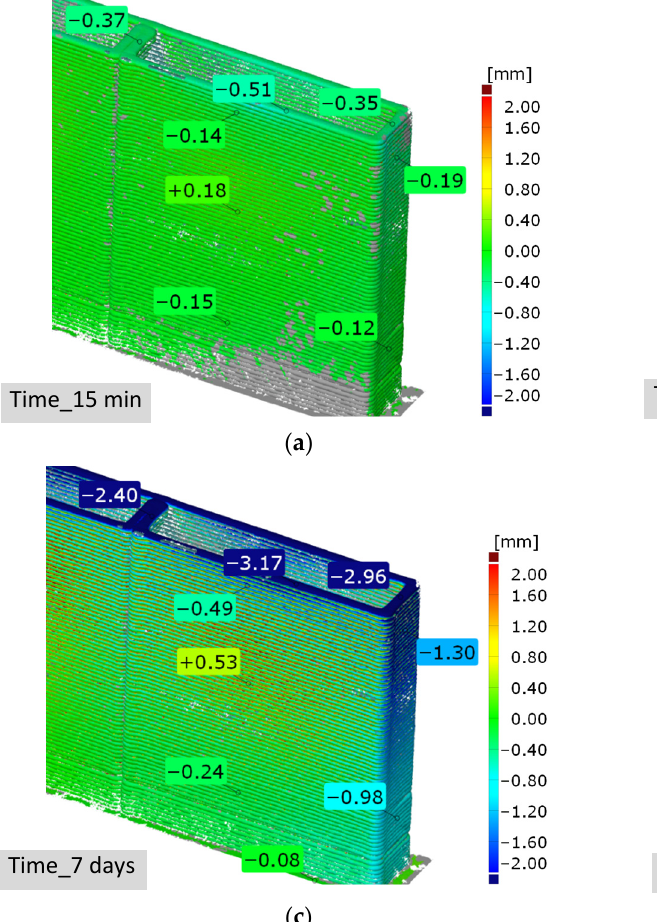
Figure 10. Inspection section of the 35th layer (half-height) expressing the deviations between the printed and nominal model (28-day scan).